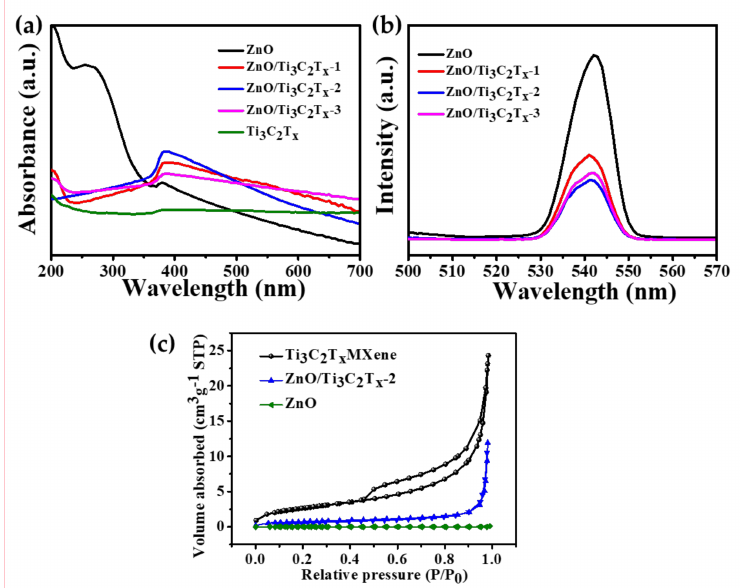
Figure 5. ( a ) UV-Vis absorption spectra, ( b ) PL spectra, and ( c ) N 2 adsorption / desorption isotherms of as-synthesized samples.